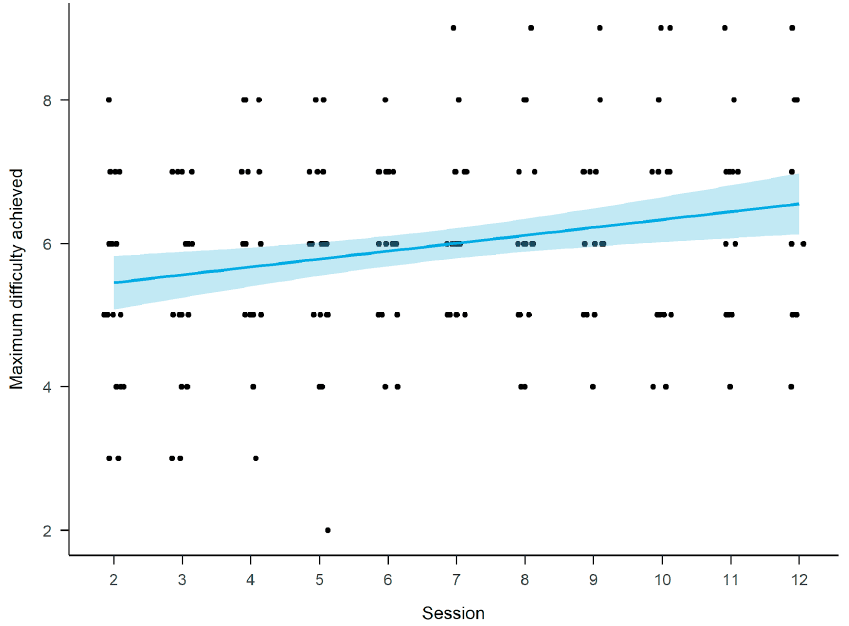
Figure 3. Maximum difficulty achieved in Virtual Supermarket Shopping Task plotted as an effect of the session.